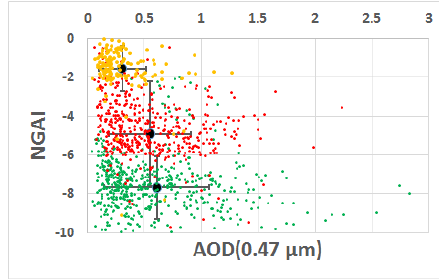
Figure2. Same as Figure 1, but after normalization.